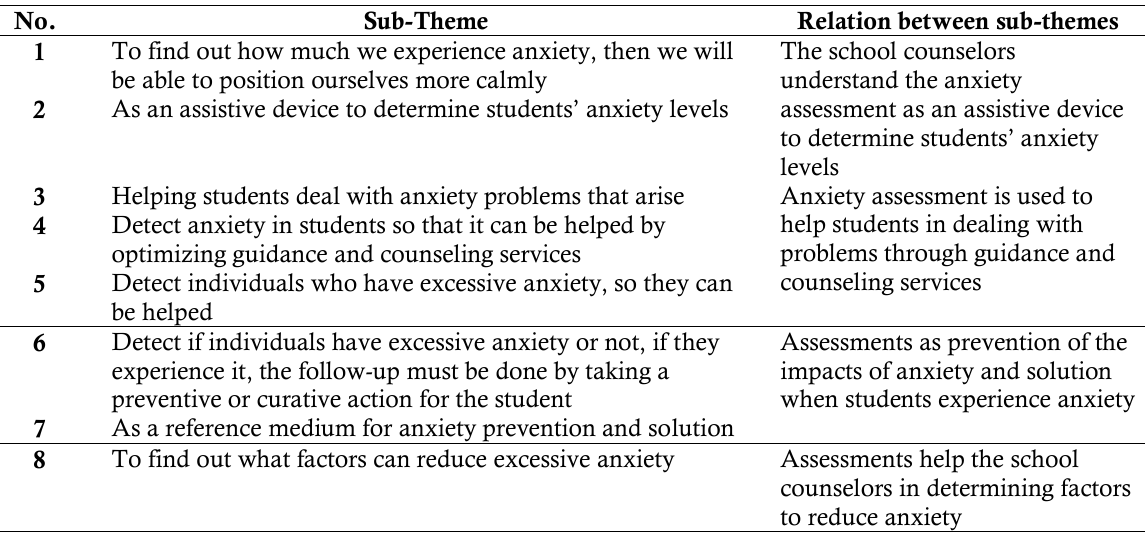
Table 2. The results of reduction regarding the benefits of using anxiety assessment No. Sub-Theme Relation between